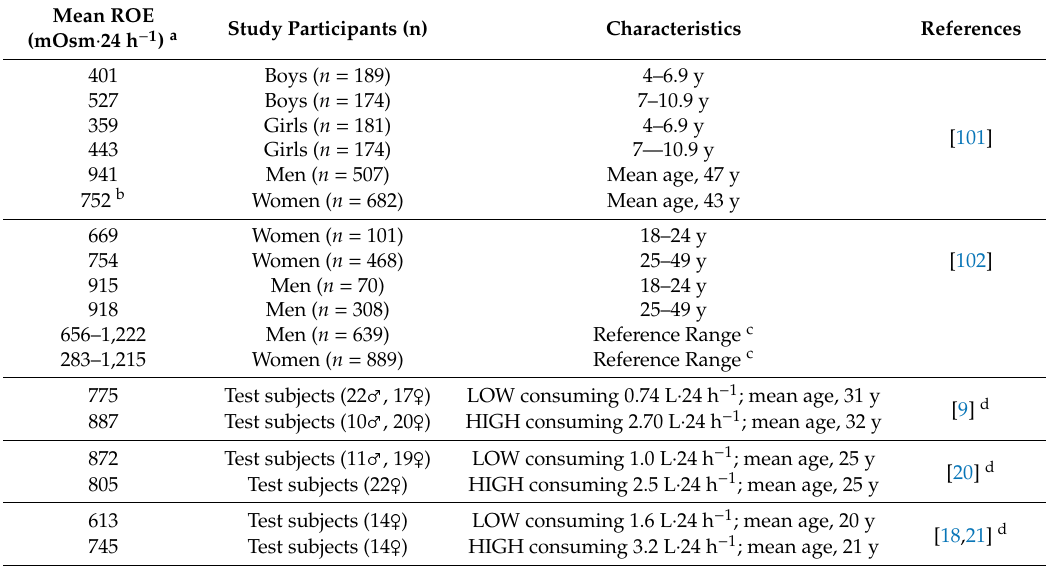
Table 3. Renal osmolar excretion (ROE) in 24-h urine samples of adults and